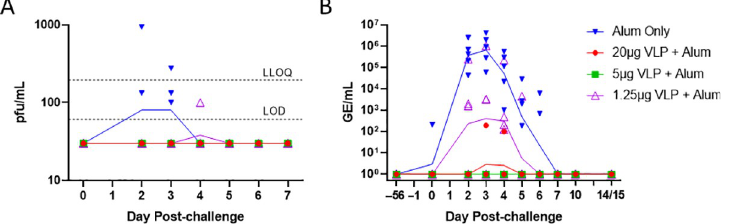
Fig 8. Protection against ZIKV viremia following challenge. Following ZIKV challenge on day 56, blood samples were tested for infectious virus by (8A) plaque assay and (8B) RNAemia by RT-qPCR. GMT for each titer is shown by a line, individual titers by symbols, and plaque assay LLOQ (195 PFU/mL) and LOD (61 PFU/mL) by dashed lines. Note that the RT-qPCR assay does not have an established LLOQ or LOD, so all data are presented and samples with undetectable ZIKV RNA shown at 10 0 GE/mL. Statistical differences between groups (by Kruskal-Wallis analysis plus Dunn’s multiple comparison tests for all pairwise comparisons) are indicated in the text.